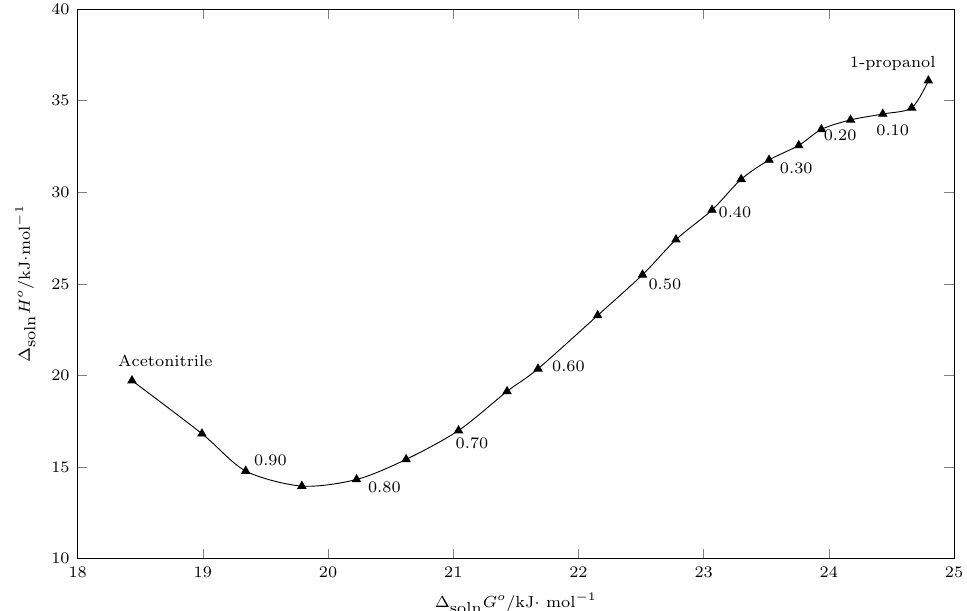
Figure 6. Enthalpy–entropy compensation plot for the solubility of SD (3) in {MeCN(1) + 1-PrOH (2)} mixtures at T hm = 297.6